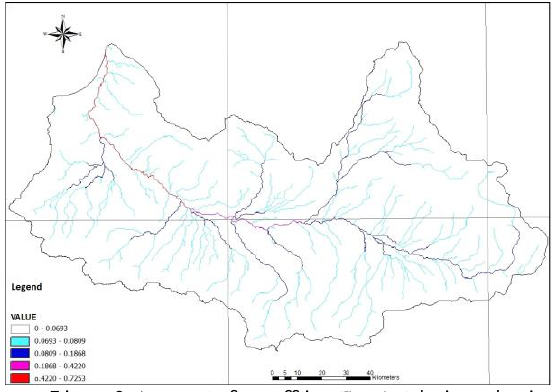
Figure 8. Amount of runoff in Zilberchai drainage basin Also runoff coefficient map (figure 9) was obtained by dividing runoff map into the corresponding rainfall values in raster calculator. The calculated average runoff coefficient is equal to 0.71(without subtracting with the base flow) that is high. parts of the basin but in center part of basin is low.